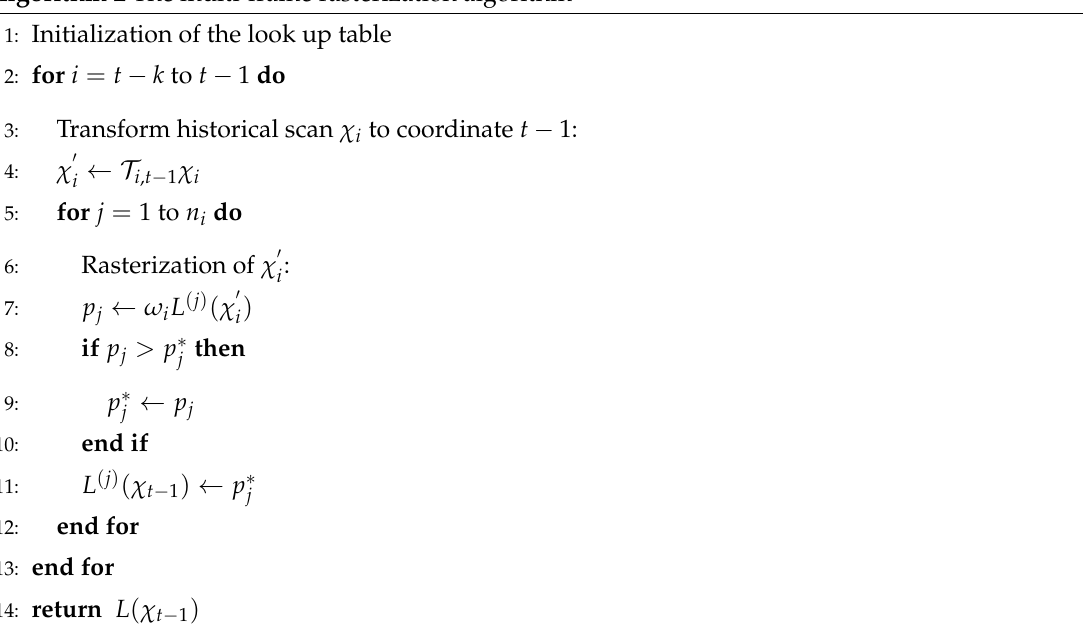
Algorithm 2 The multi-frame rasterization